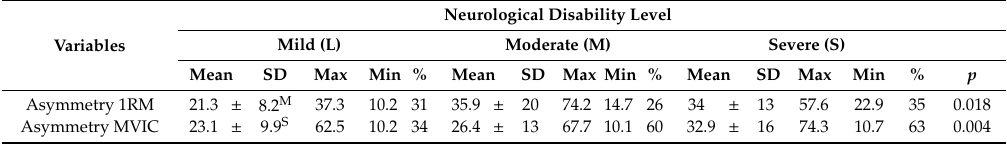
Table 10. Asymmetry of sample by neurological disability